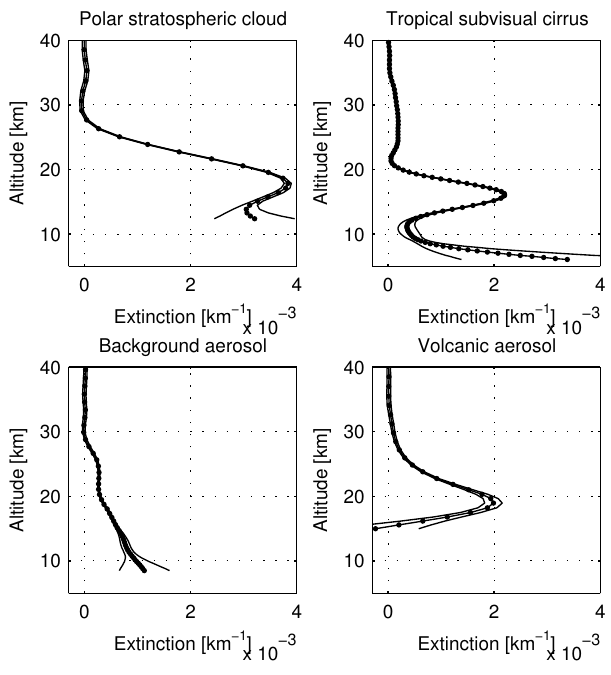
Fig. 2. Individual GOMOS particle extinction profiles with associated uncertainty: a Polar Stratospheric Cloud (30/7/2003, 72,57 ◦ S, 2.18 ◦ W), a tropical subvisual cirrus cloud (7/10/2002, 0.52 ◦ S, 78.69 ◦ E), background stratospheric aerosols (12/9/2003, 43.34 ◦ S, 137.36 ◦ W), volcanic stratospheric aerosols (9/1/2007, 4.52 ◦ S, 27.15 ◦ E). All plots have the same scale, in order to facilitate comparisons of magnitude.